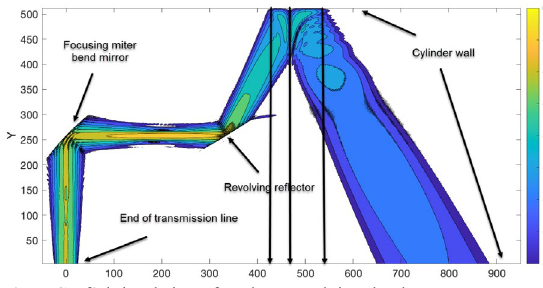
Fig. 5. Surf3d simulation of RF beam path into load